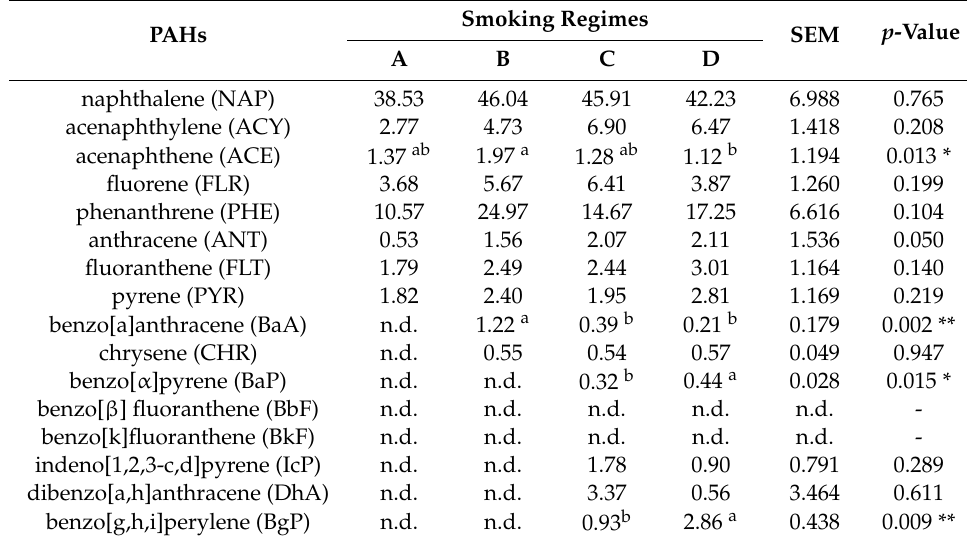
Table 3. Individual PAHs ( µ g / kg wet weight) determined in dry-cured sausages under di ff erent smoking regimes.